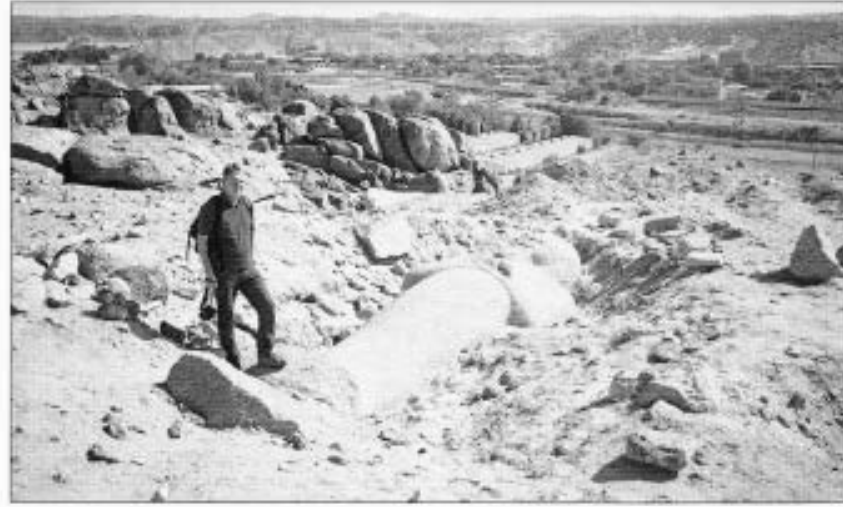
Figure 6 Osirid statue (New Kingdom} lying in the Aswan granite quarries.